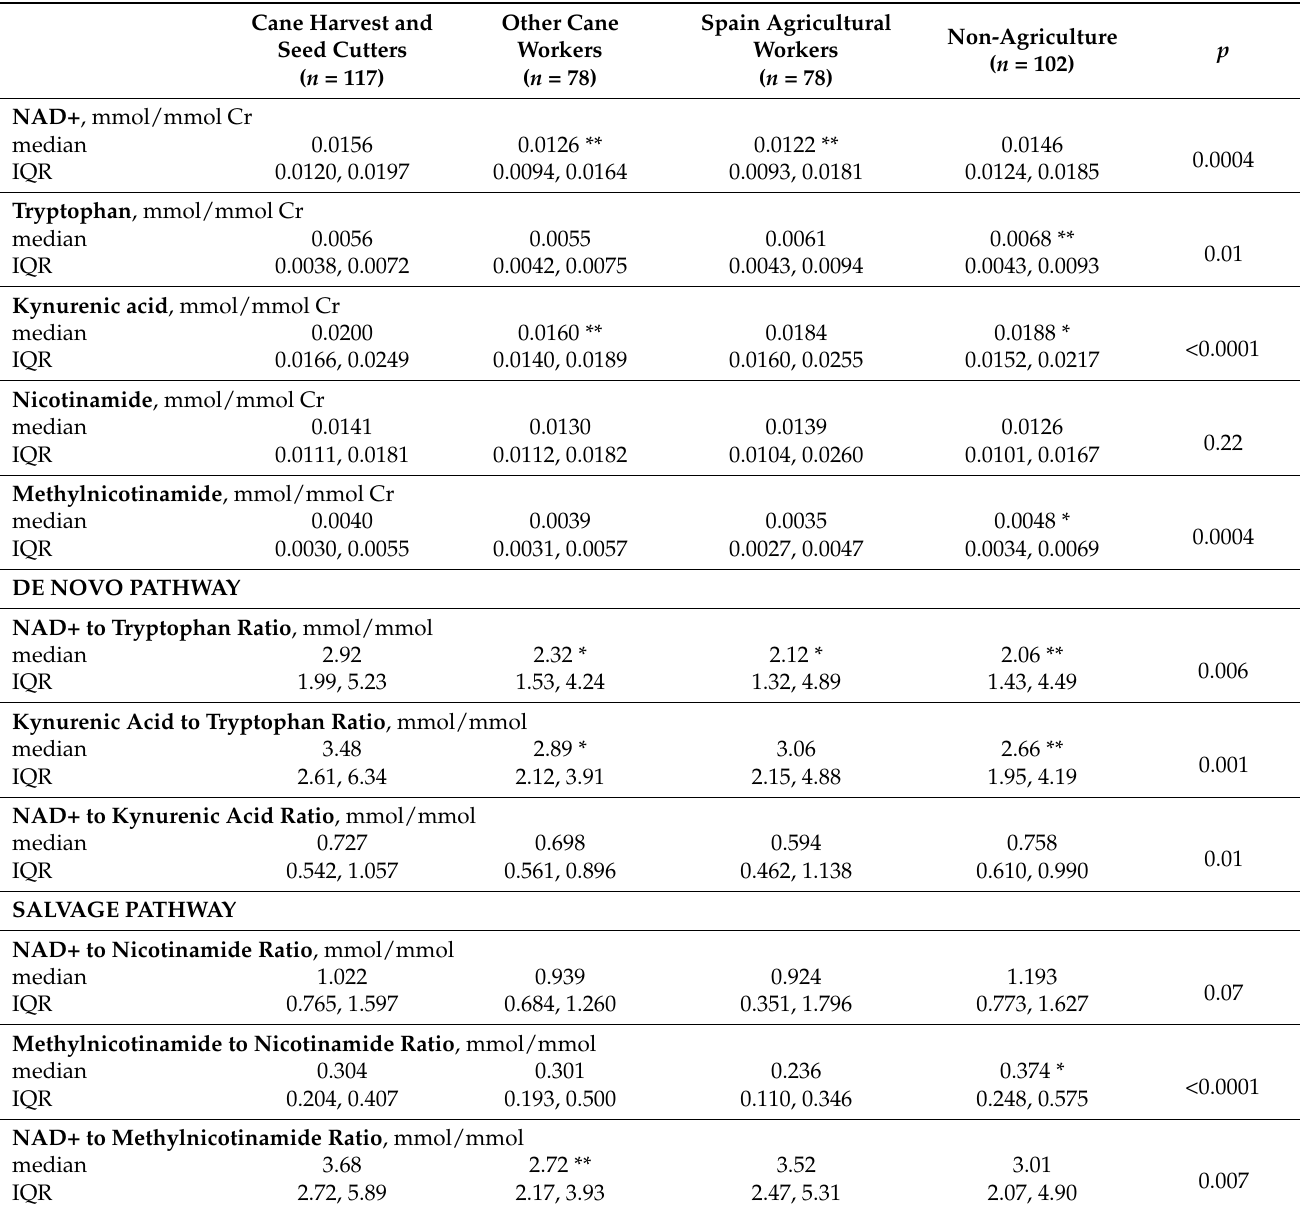
Table 3. Key urinary metabolites of NAD+, tryptophan, and nicotinamide metabolism. Groups hypothesized to be at greater risk of metabolic derangement along these metabolic pathways are orange, at less risk blue. * indicates a statistically significant difference from the cane harvest/seed cutters group at a p -value of <0.05, ** at <0.01. NAD+, nicotinamide adenine dinucleotide; Cr, urine creatinine; IQR, interquartile